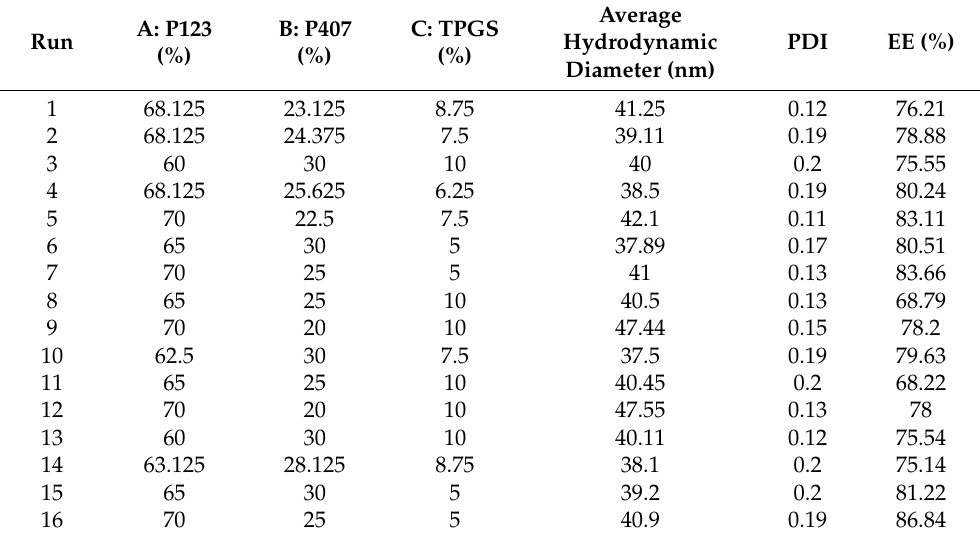
Table 1. Experimental design matrix’s critical process parameters and the critical quality attributes related to